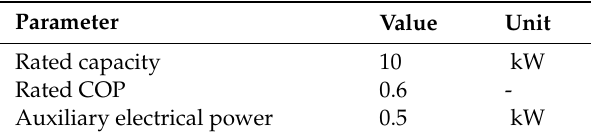
Table 6. Description of the lithium bromide absorption